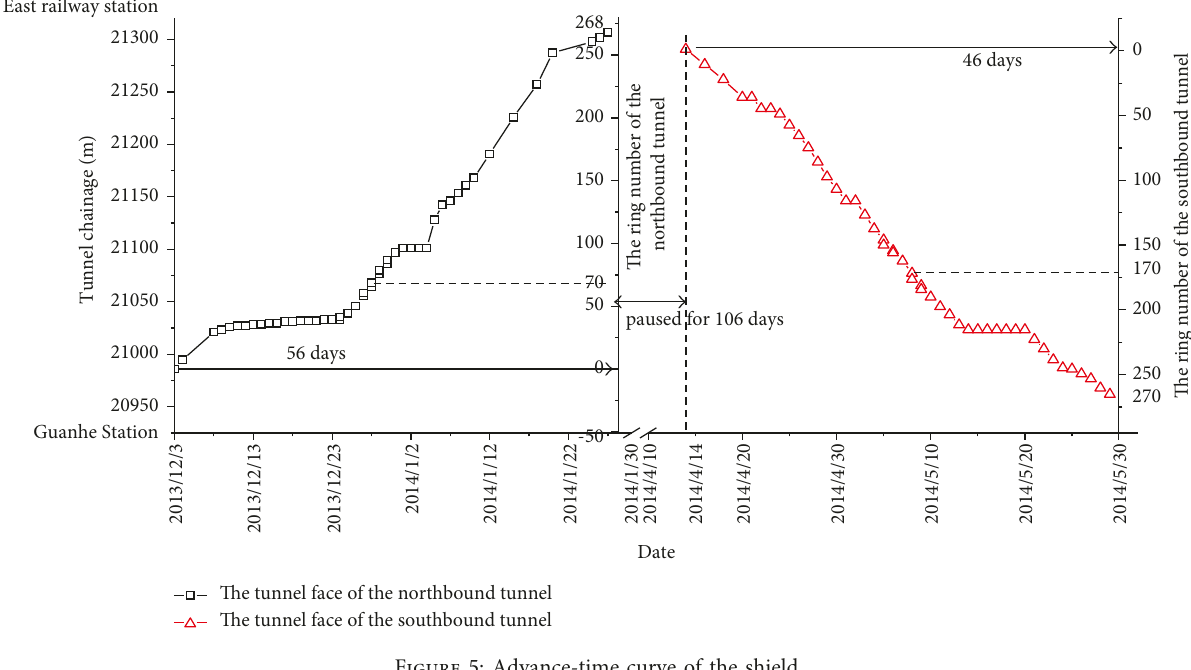
Figure 5: Advance-time curve of the shield.